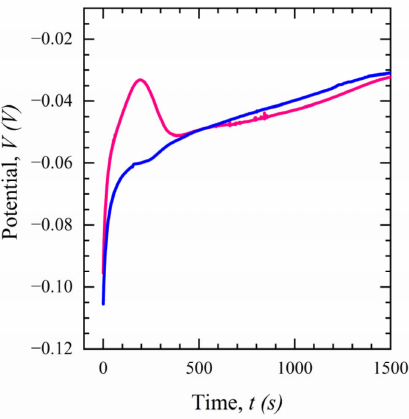
Figure 9. OCP profiles of two functionalized sensors in 0.1 M PBS.